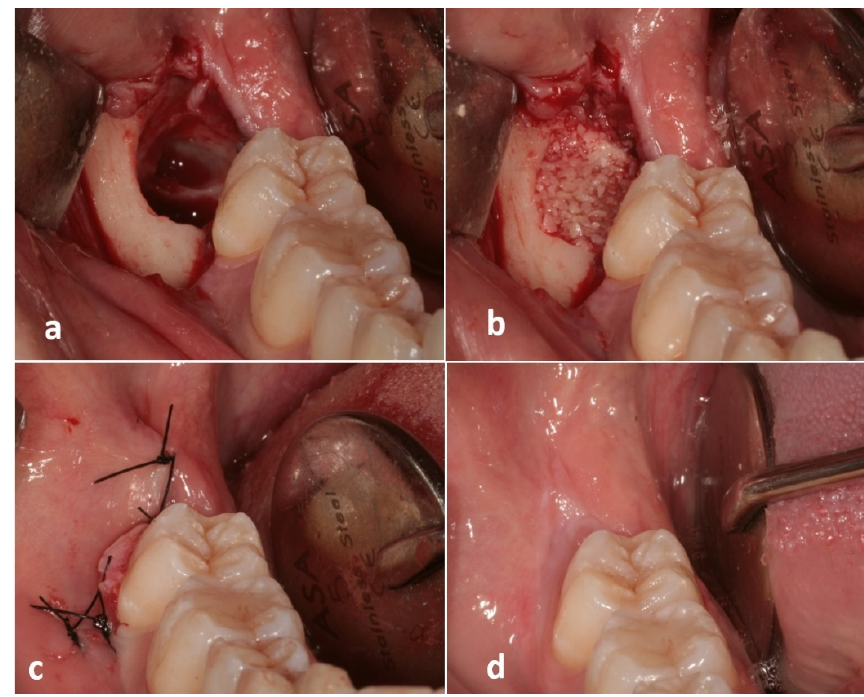
Figure 2. Clinical images showing the treatment sequence at an experimental site: ( a ) Post-extractive third molar socket; ( b ) Autogenous dentin graft filling the socket; ( c ) Flap suture with primary closure; ( d ) Soft tissue healing at 180 days after